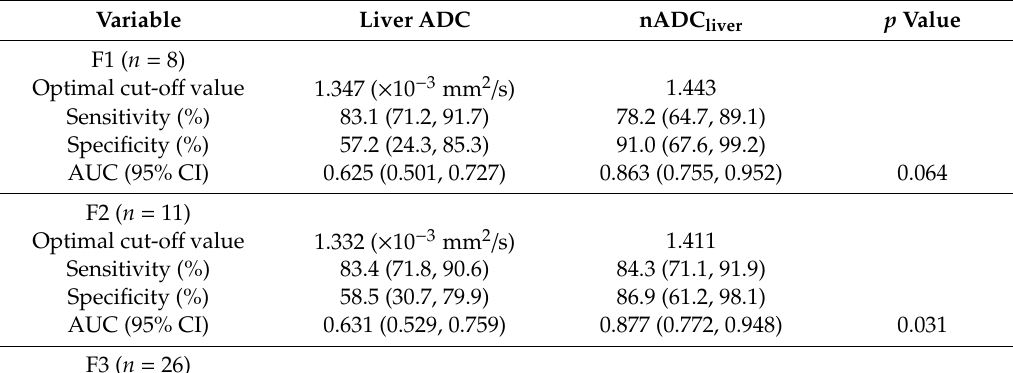
Table 3. Comparison between liver ADC and nADC